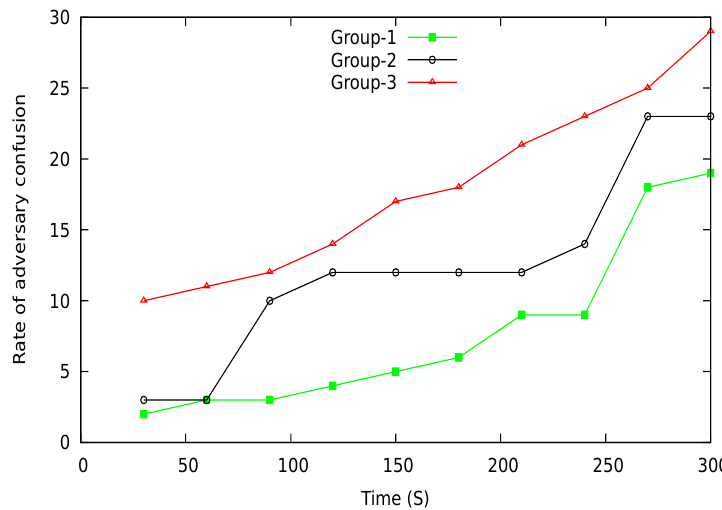
Figure 23. Adversary confusion or ASS with different time